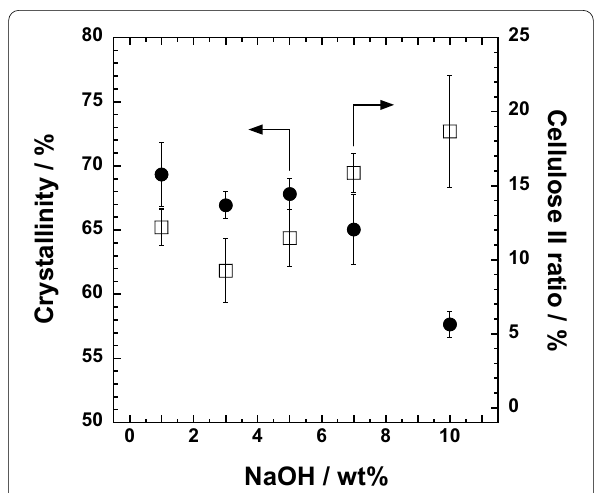
Fig. 2 Crystallinity (closed circles) and cellulose II ratio (open squares) calculated from WAXD profiles ( n 3–5) of cellulose nanofibrils = treated with aqueous NaOH solutions. NaOH concentration: 1.0, 3.0, 5.0, 7.0, and 10.0 wt%